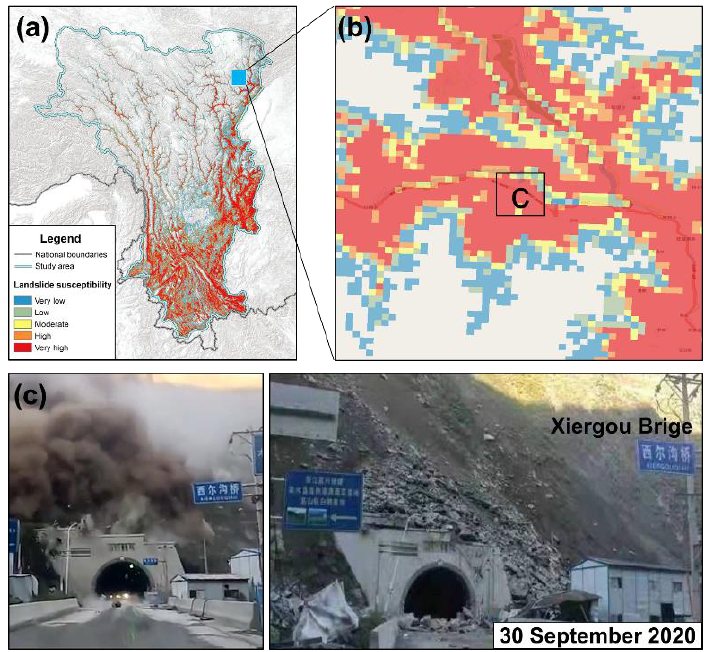
Figure 14. LS assessment results and comparison with landslide disaster information obtained from the Internet media. ( a ) is the LS map of the Hengduan Mountains region. ( b ) is the zoom-in view of LS map. ( c ) shows the scene when the landslide occurred.